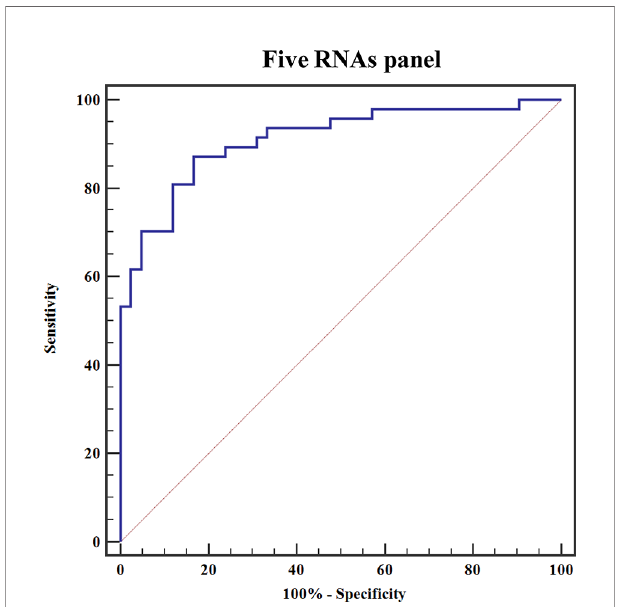
FIGURE 7 | ROC curve for discriminating early-stage BCa patients from HCs based on the constructed fi ve exosomal RNAs